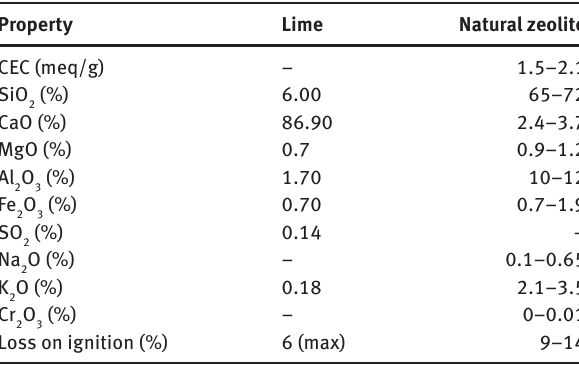
Table 3: Physical and chemical composition of the additives. Property Lime Natural